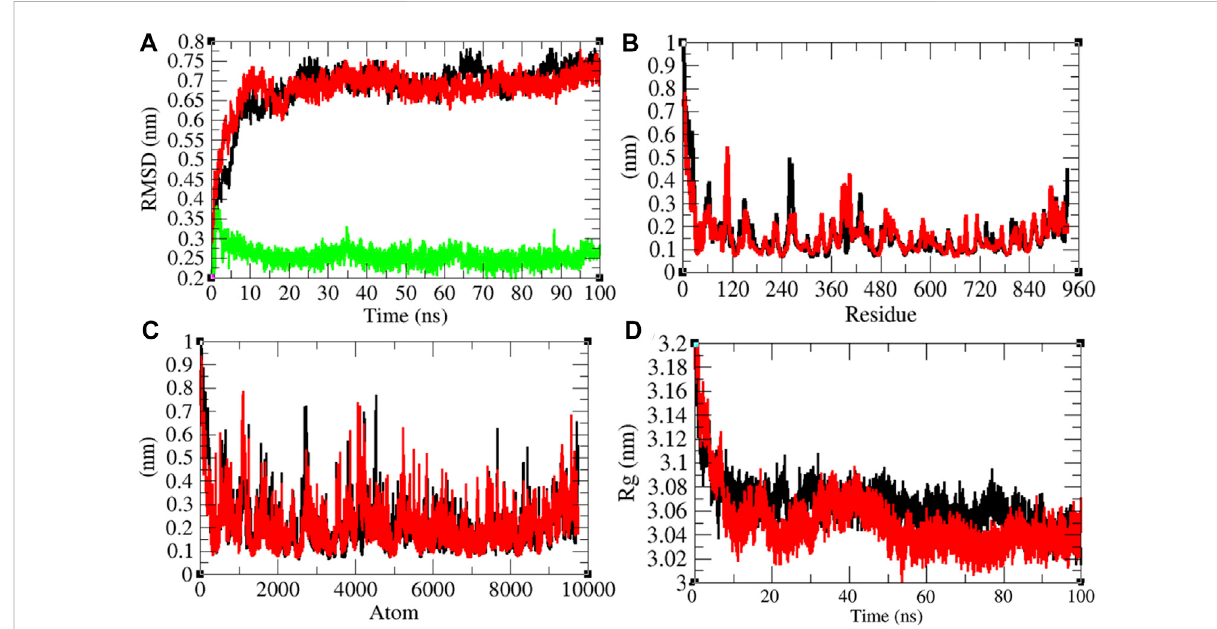
StructuraldynamicsofRDRP. (A) RootmeansquaredeviationsplotforRDRP(black),RDRP-remdesivir(red),andremdesivir(green)asafunction of time. (B) Root mean square fl uctuations vs. residues. (C) Root mean square fl uctuations vs. atoms. (D) Radius of gyration ( R g ) plot.